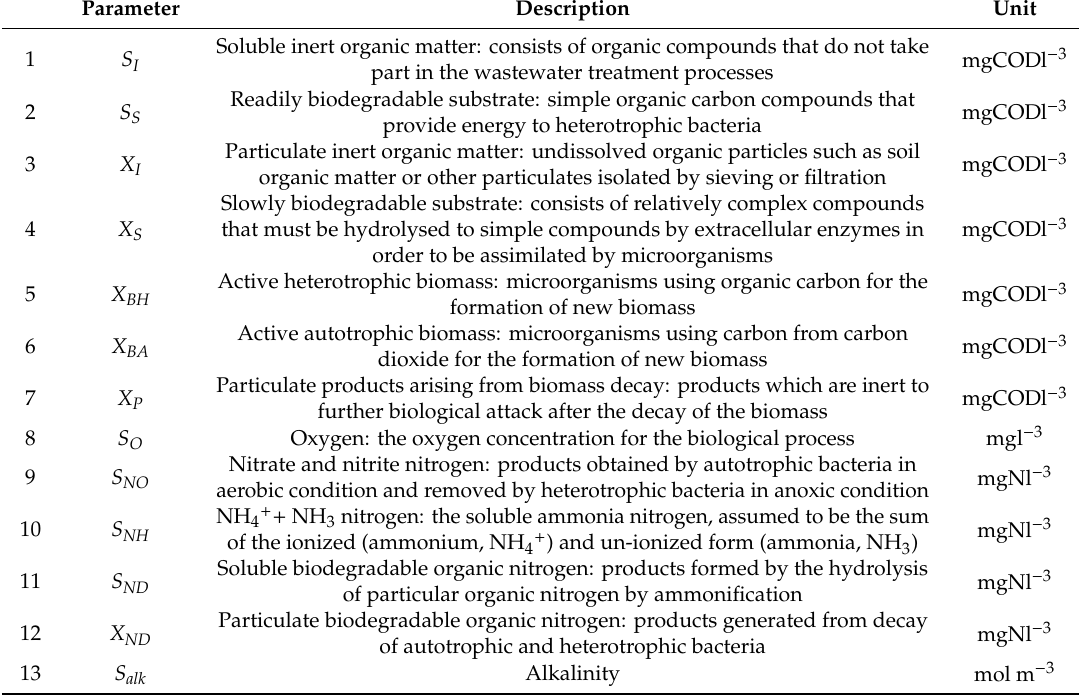
Table A1. ASM1 main